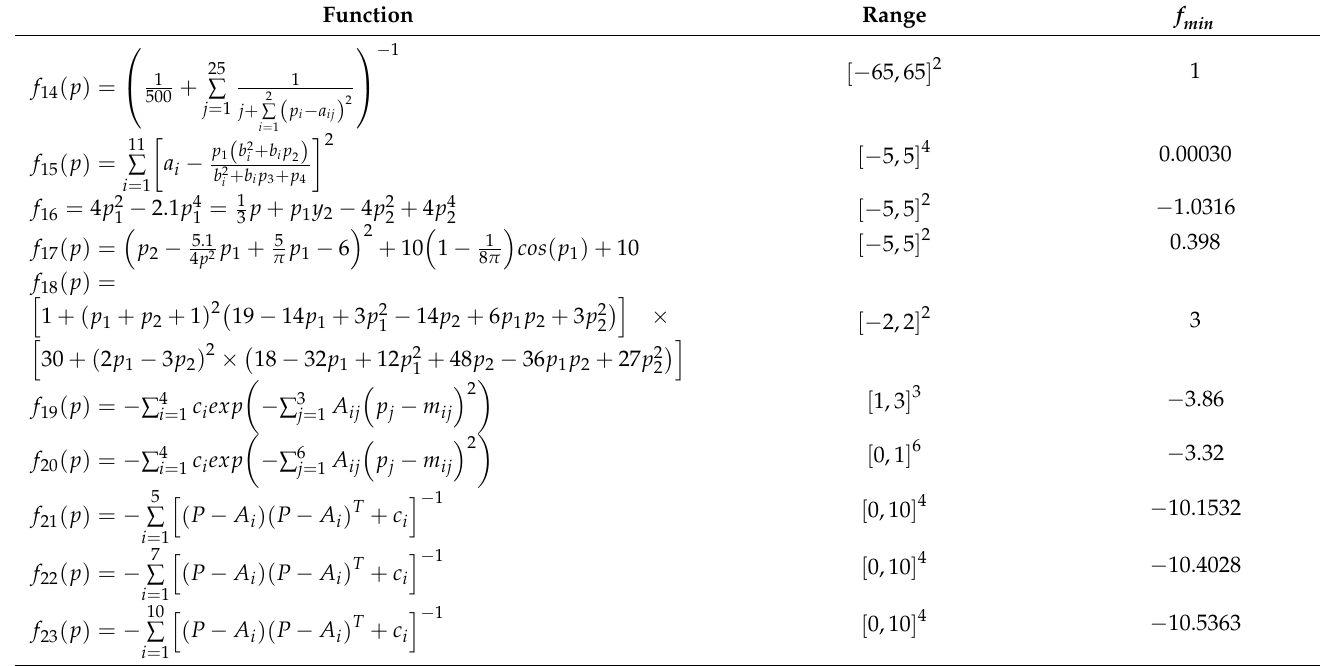
Table 5. Fixed dimension multimodal benchmark functions.